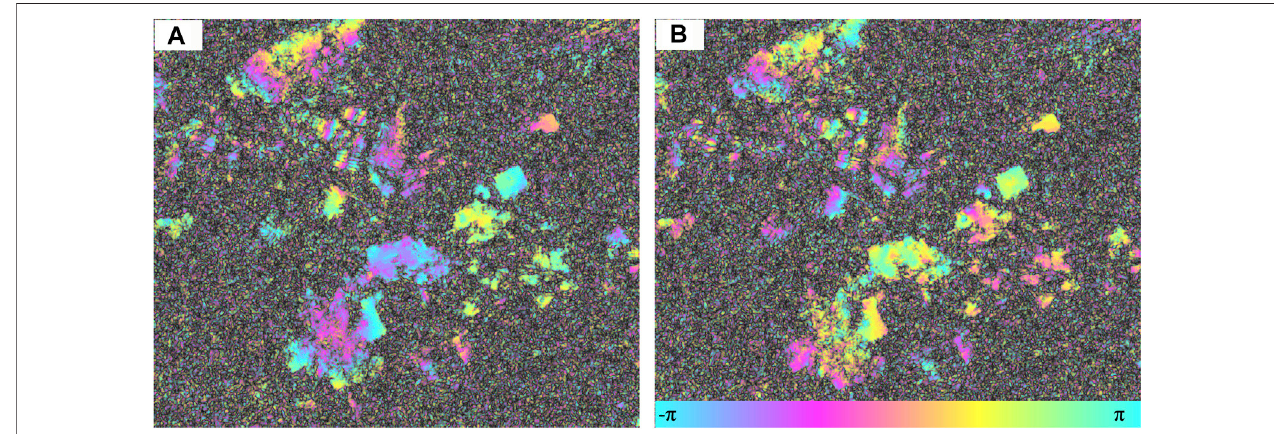
FIGURE 3 | TSX interferogram (A) before and (B) after subtracting the initial deformation derived from ASAR acquisitions. The temporal and perpendicular baselines are 429 days and 25 m, respectively.